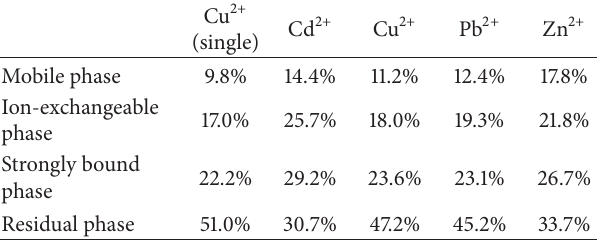
Table 5: Average contents of mobile phase, ion-exchangeable phase, strongly bound phase, and residual phase of single Cu 2+ ions and Cd 2+ , Cu 2+ , Pb 2+ , and Zn 2+ ions adsorbed from their